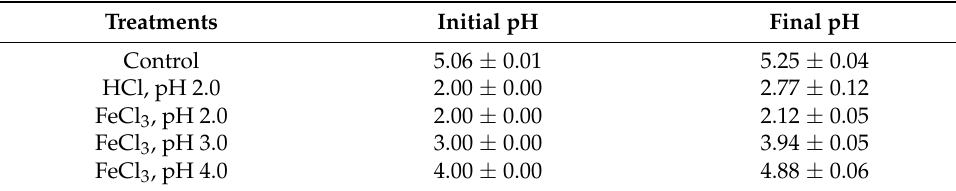
Table 2. Solution pH values during the washing